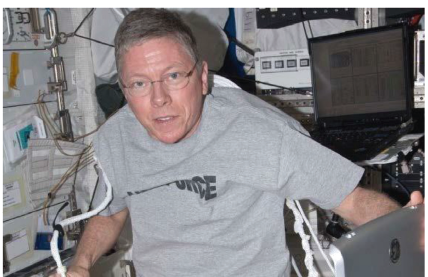
Figure 3: American astronaut Michael E. Fossum working with CU onboard of the International Space